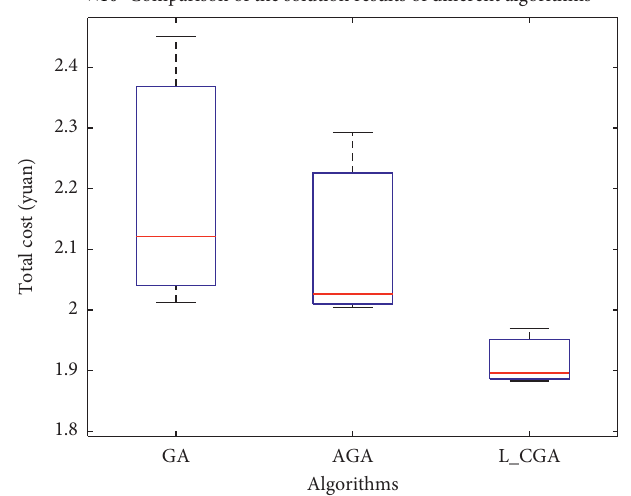
Figure 10: Comparison of the solution results of different algorithms.